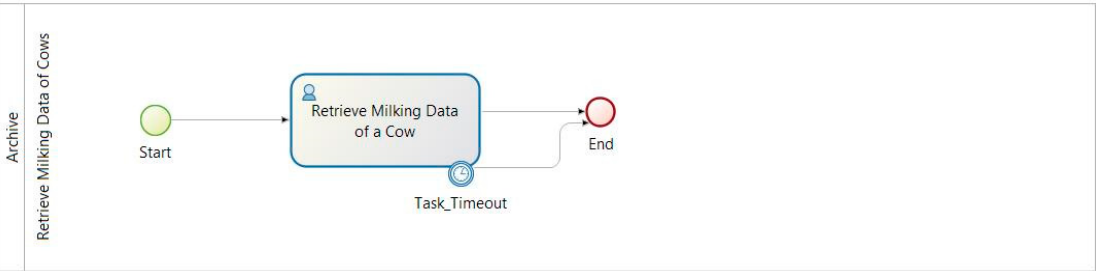
Figure 13. Example of a business process used by the software application to retrieve a set of data from